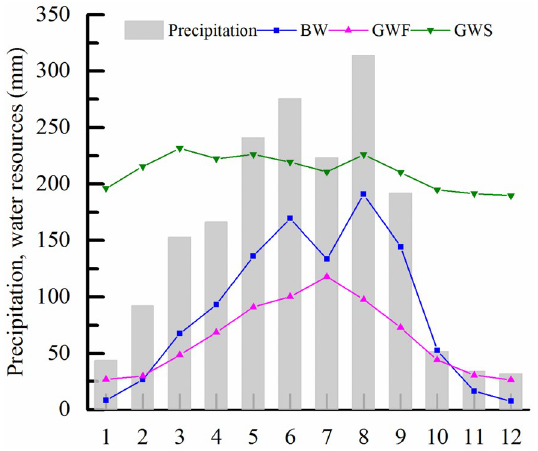
Figure 4. Average monthly variation of BW and GW resources in the